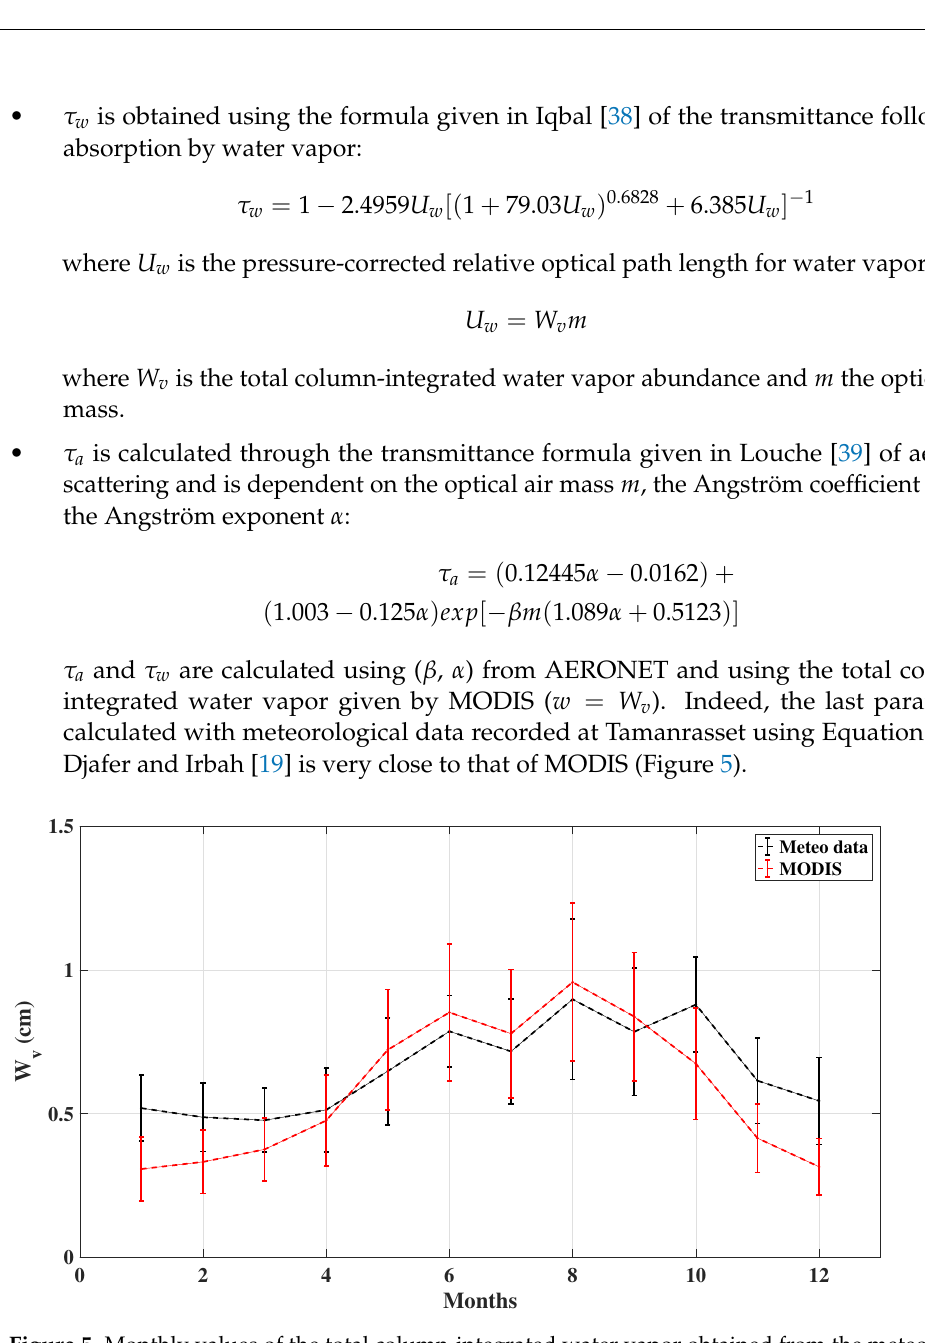
Figure 5. Monthly values of the total column-integrated water vapor obtained from the meteorologi- cal data recorded at Tamanrasset and from